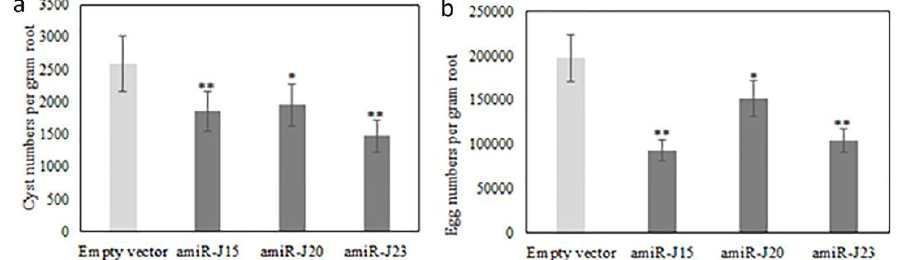
Figure 7. Comparison of H. glycines cyst ( a ) and egg ( b ) densities on roots of transgenic composite plants. Composite plants transformed with the empty vector were used as negative controls. Bars with one or two asterisks are significantly different from the empty vector control at p < 0.05 (*) and 0.01 (**), respectively. Error bars represent the standard error of the mean based on at least three independent bioassay experiments, with experiment treated as a random effect.